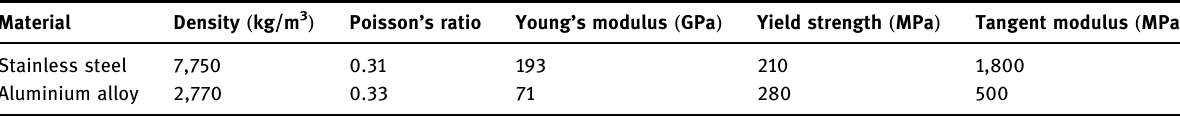
Table 1: Elastic and plastic material properties of stainless steel and aluminium alloy